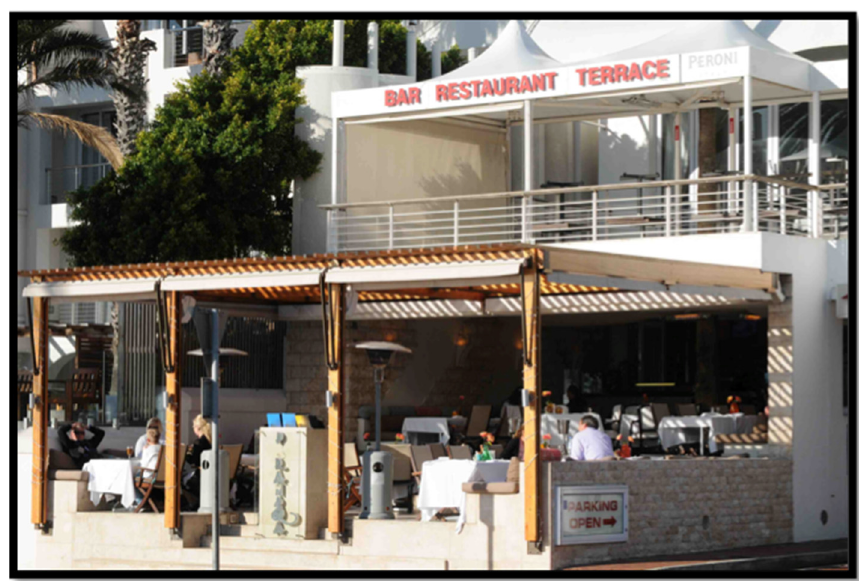
Figure 5. Kick Ass on Long Street; interview with Ibrahim.